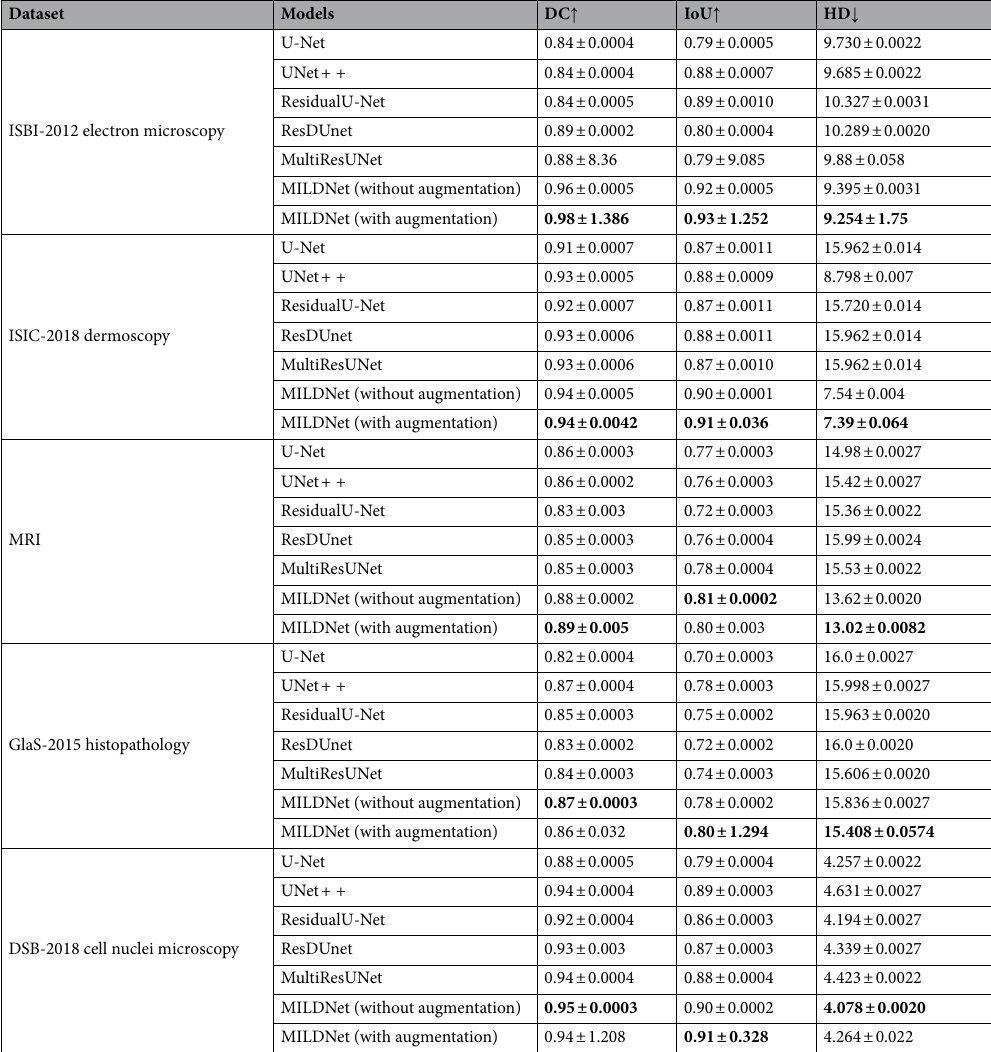
Table 5. MILDNet outperforms the classical U-Net and other baselines in segmenting the biomedical images using the test sets. For the MILDNet, we have also applied data augmentation techniques during training. The evaluation metrics are calculated from the network output without applying further post-processing on the predicted binary masks. ↑ : The higher value is better; ↓ : The lower value is